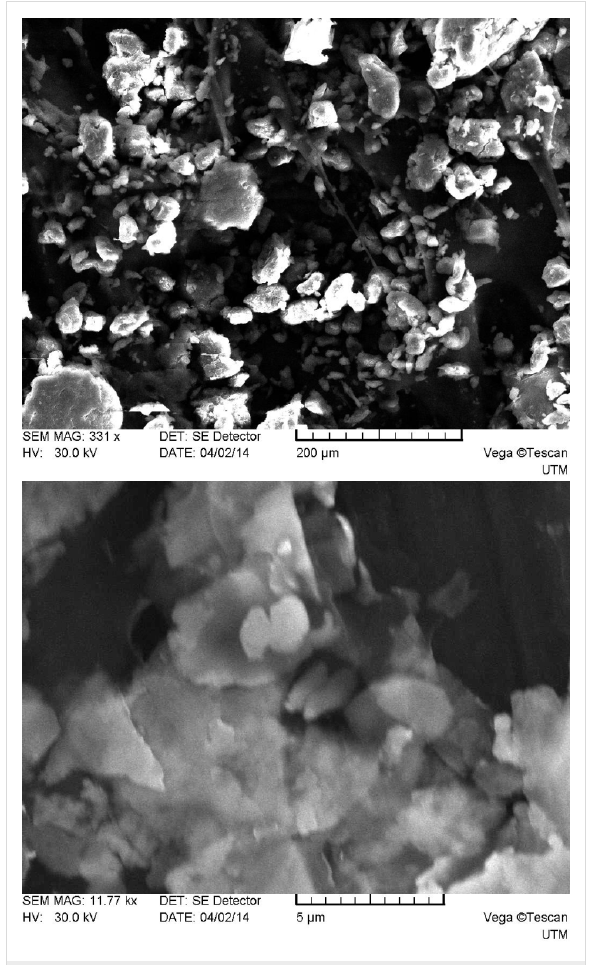
Figure 2: SEM micrographs of system 1 particles (top: magnification 331×, bottom: 11770×).